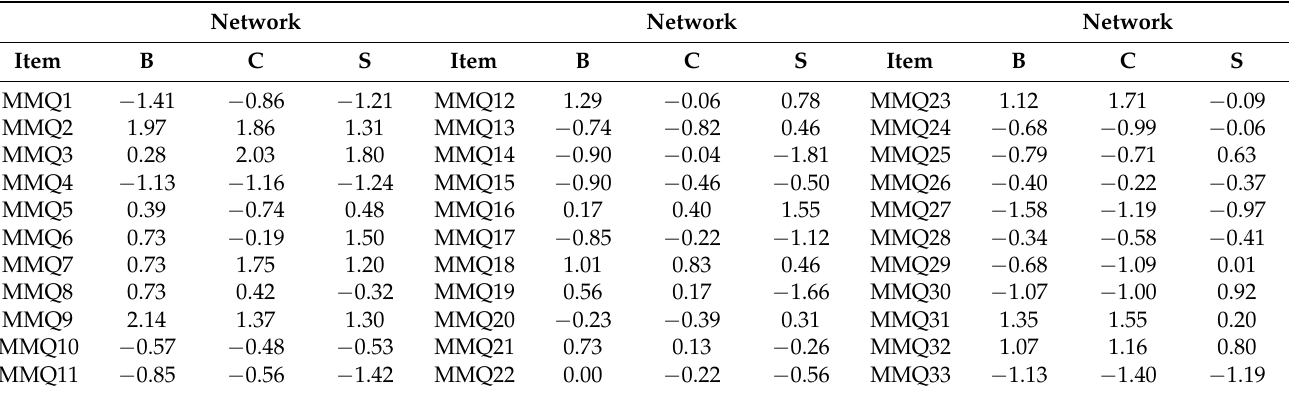
Table 4. Centrality measures per MMQ item.